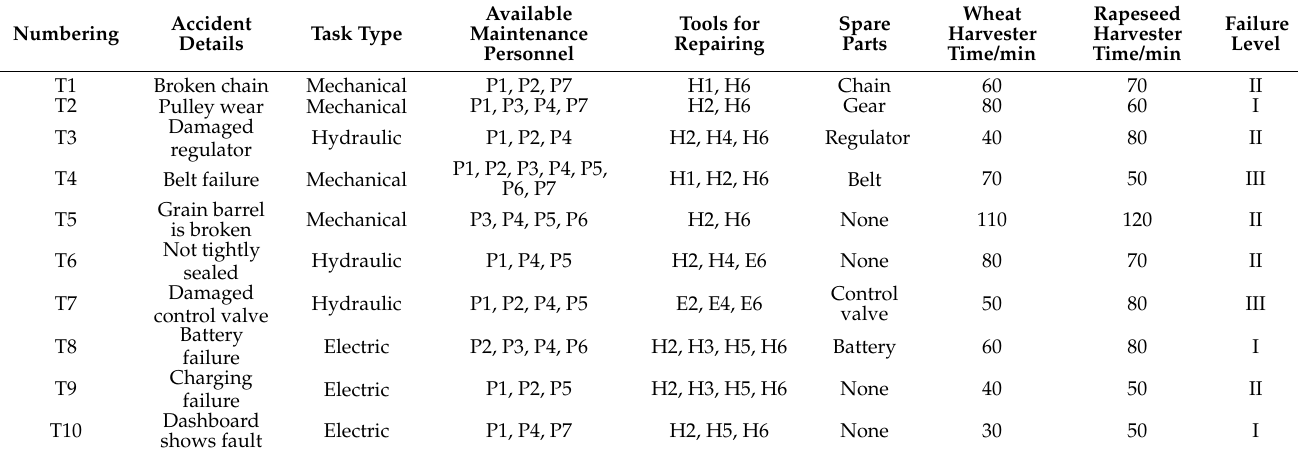
Table 3. Requirement information and processing time of tasks during harvester maintenance.